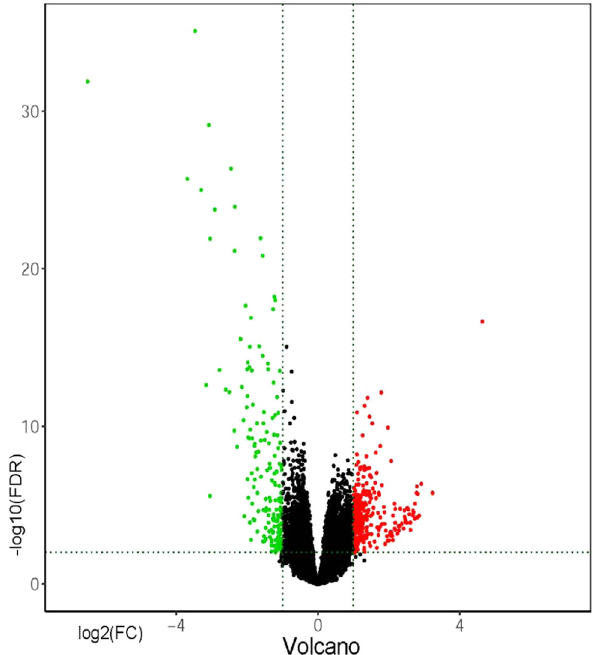
Figure 1: The DEGs of metastasizes and primary tumors. The y - axis value is log FC, and the x - axis value is − log 10 ( FDR ) . The red plots represent the upregulated DEGs, while green plots represent the downregulated